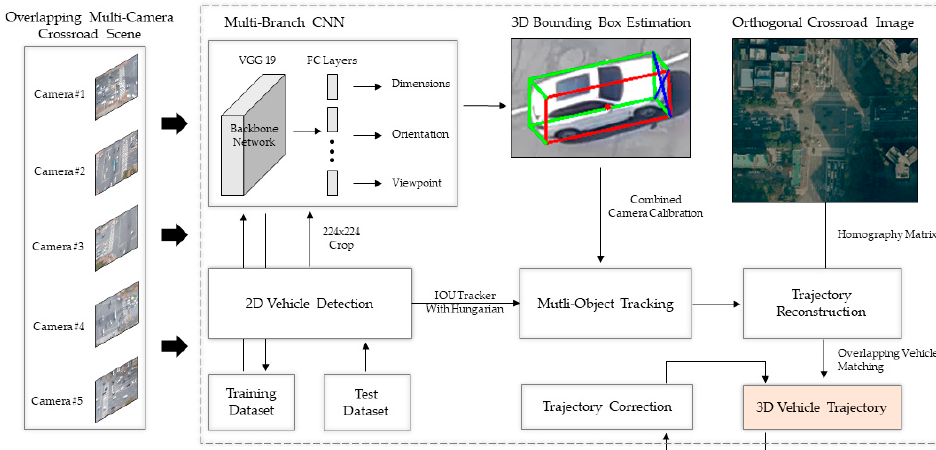
Figure 2. Single-camera scenes from areas ( a – e ) in Figure 1b.